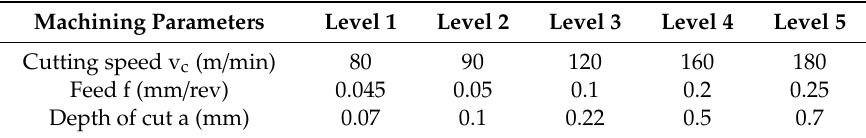
Table 1. Turning conditions.